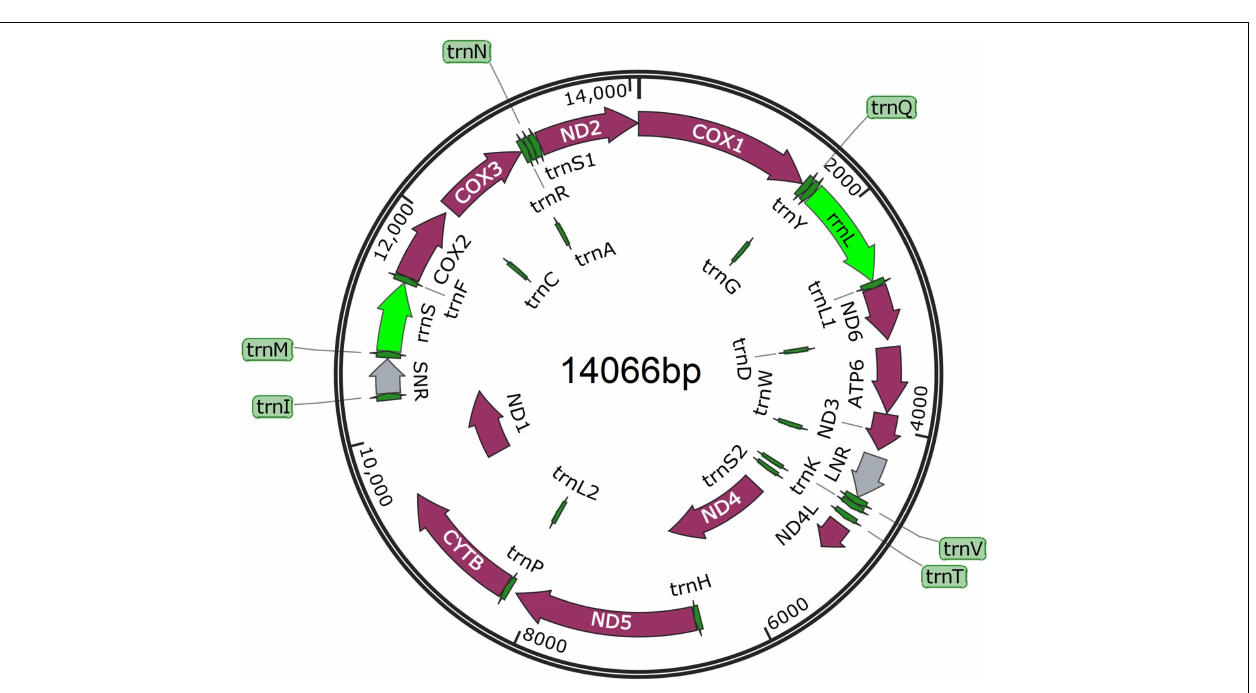
Mediorhynchus grandis in the order Gigantorhynchida formed a clade with Moniliformis moniliformis ( Figure 5 ), this relationship of ribosome DNA (SSU) (Lynggaard et al.,